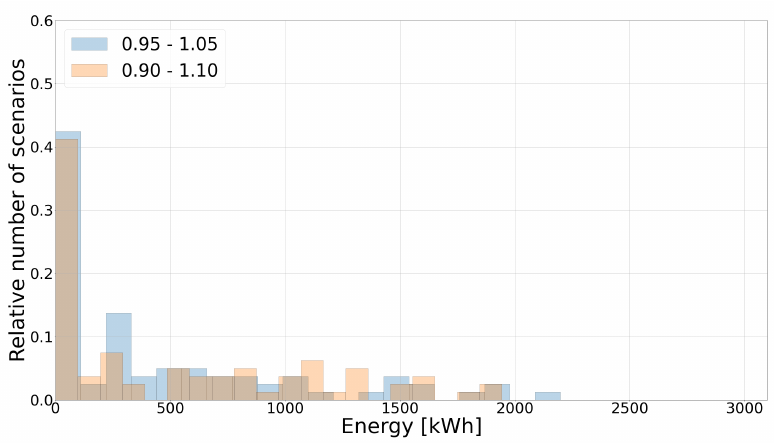
Figure 8. Histogram of M R values for all prosumption realization scenarios.